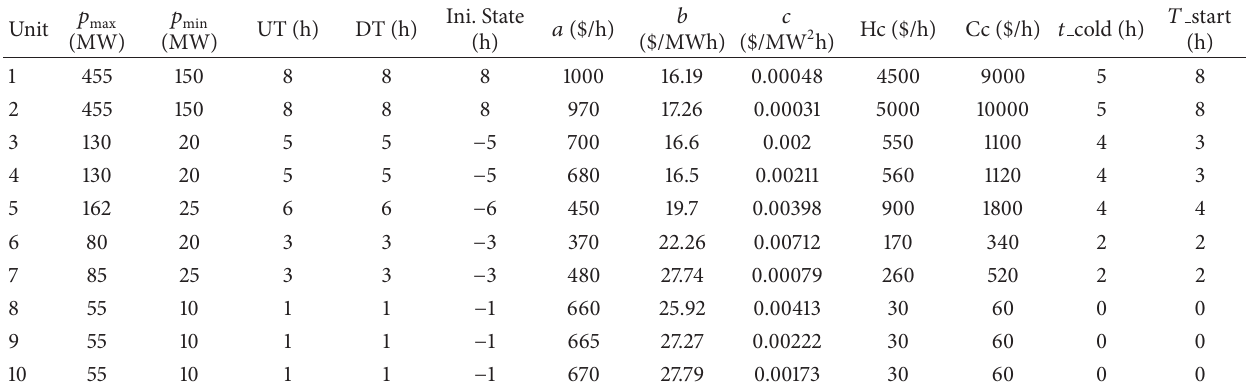
Table 1: Generator data.